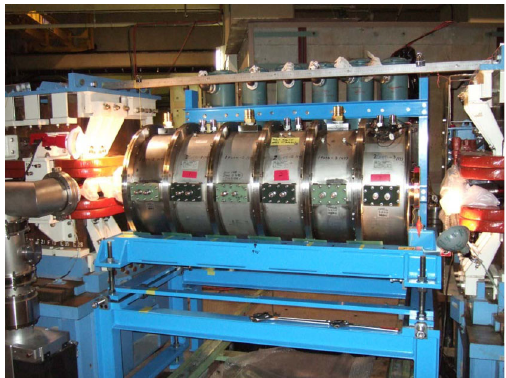
FIG. 30. Acceleration cells installed in the straight section of the